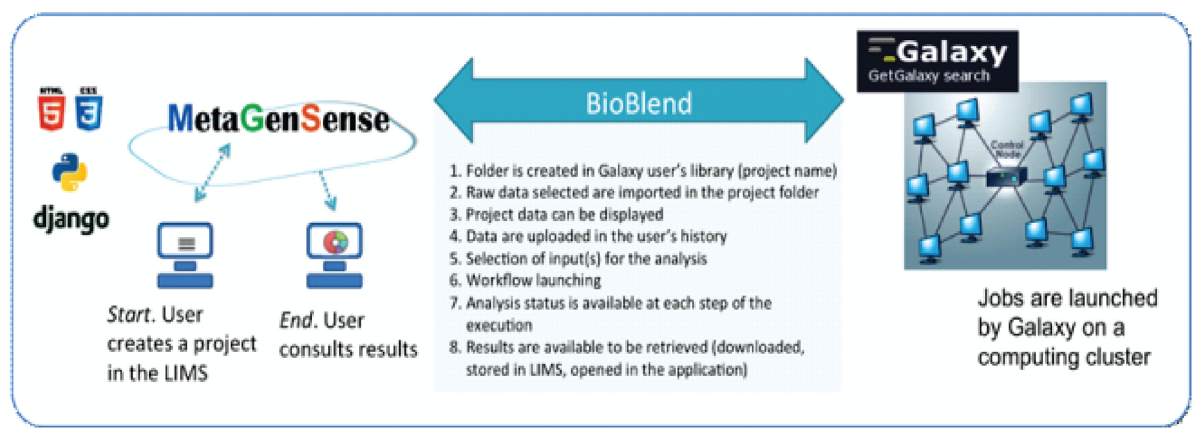
Figure 1. Communication details between MetaGenSense and Galaxy using